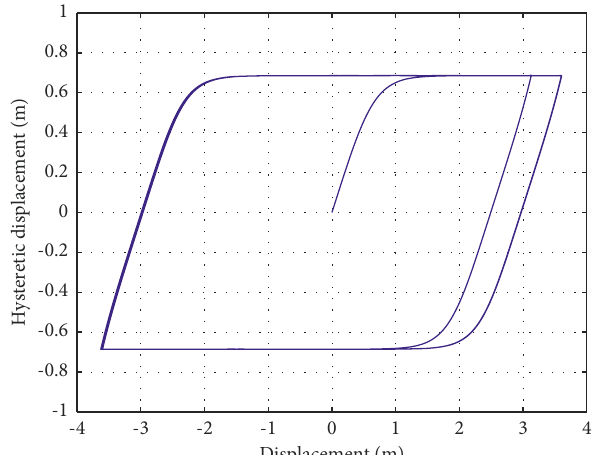
Figure 8: Hysteresis loop of the non-linear system.